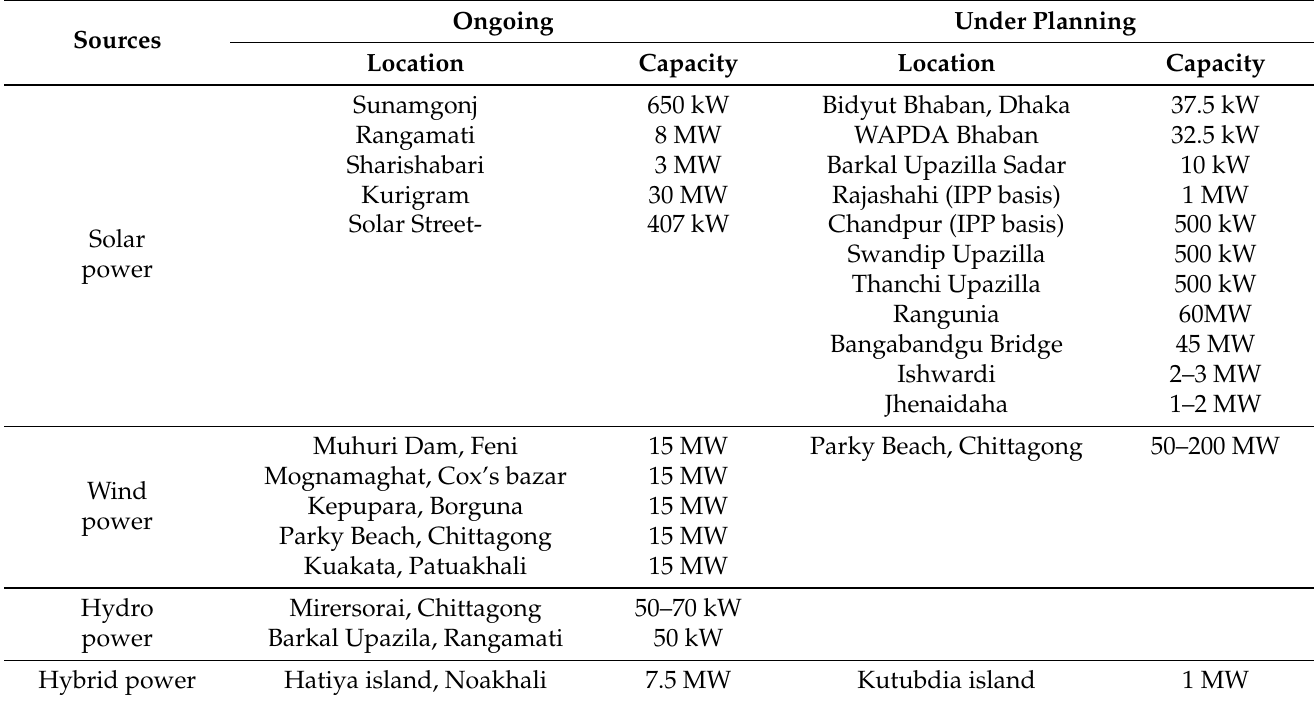
Table 8. Future RE projects in Bangladesh